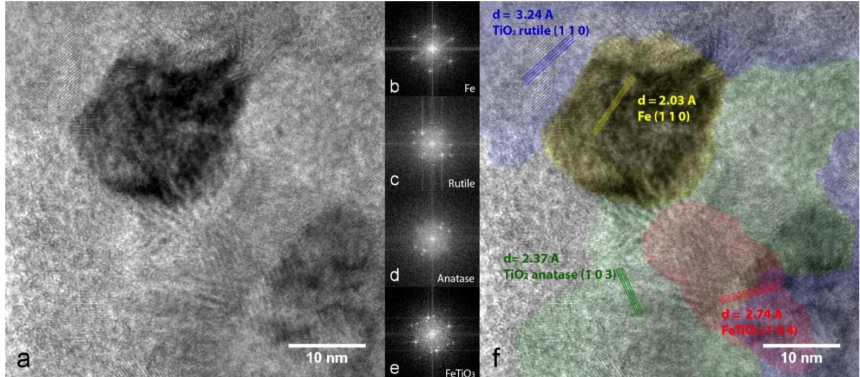
Figure 11. ( a ) HR-TEM image of the Fe/TiO x sample after 24 h in 1 MPa H 2 at 400 ◦ C; ( b , e ) FFTs performed in selected areas as indicated in the crystalline phase distribution map in ( f ), which highlights the lattice planes of α -Fe (yellow) rutile (blue), anatase (green) and ilmenite